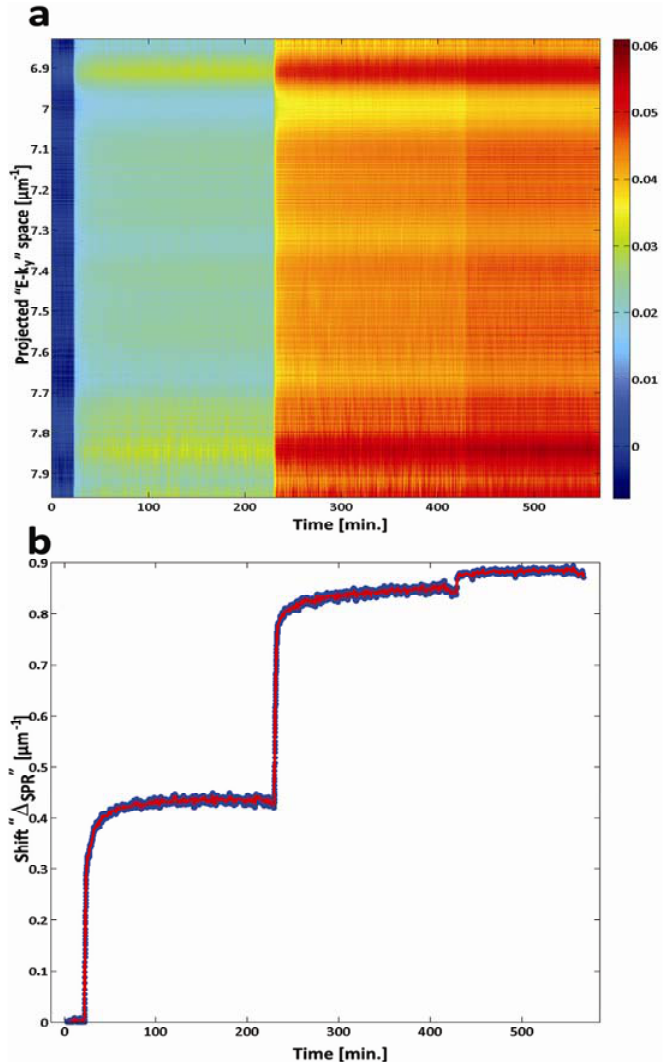
Figure 4. Detection of H3N2 IAV with a QW-SPR device. ( a )  and time, as the neutravidin (0 < t  230 min), biotinylated polyclonal IAV H3N2 antibodies (240 < t  420 min) and inactivated IAV H3N2 (t > 420 min) solutions are injected over the device and rinsed. ( b ) Cumulative SPR shift,  IAV H3N2 adsorption. A surficial shift of  rinsing the surfaces with PBS